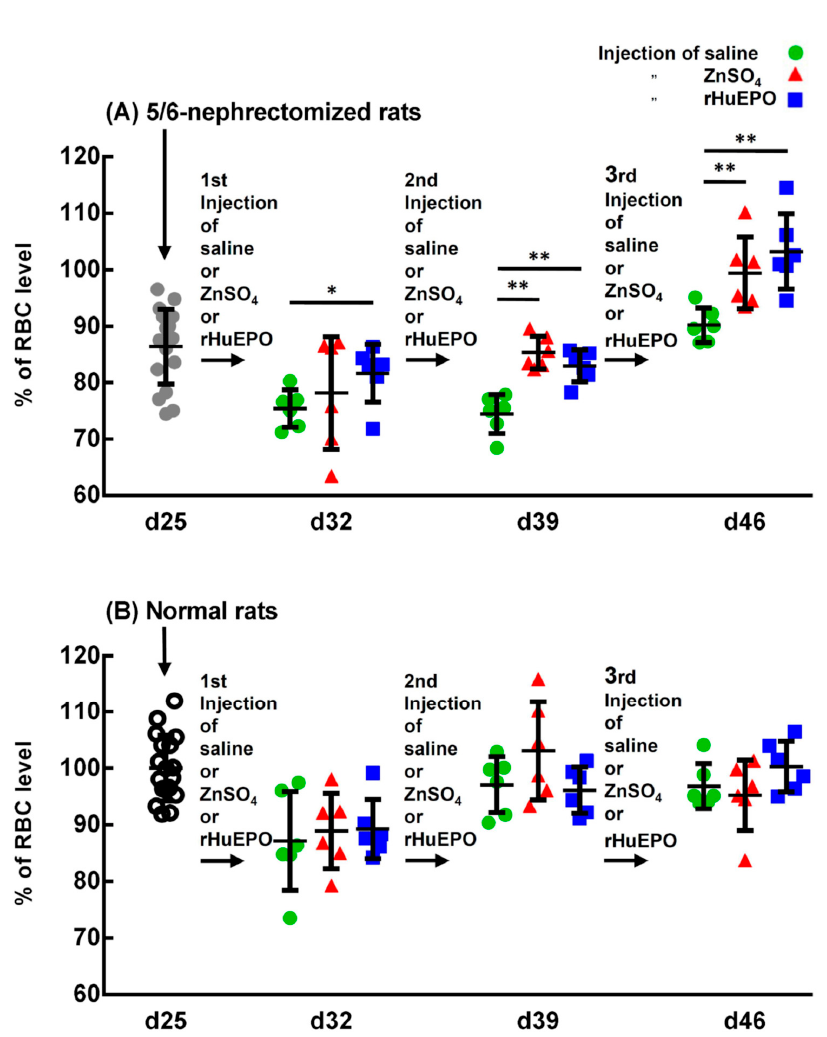
Figure 4. Comparison between the injection of saline, ZnSO 4 , or rHuEPO on the RBC level of 5 / 6-nephrectomized and normal rats. ( A ) Injection of saline, ZnSO 4 , or rHuEPO on the RBC levels of 5 / 6-nephrectomized rats. Rat blood was drawn from the 5 / 6-nephrectomized rats (25 days post surgery); then, the rats were injected with saline, ZnSO 4 , or rHuEPO. Every 7 days, blood was drawn, and saline, ZnSO 4 , or rHuEPO was injected. The collected blood was used to measure RBC levels and other hematological indices. * and **: Significant di ff erence between ZnSO 4 - or rHuEPO- and saline-injected rats (* p < 0.05; ** p < 0.01; n = 6). ( B ) Injection of saline, ZnSO 4 , or rHuEPO on the RBC level of normal rats. Normal rats (same age and lot as the 5 / 6-nephrectomized rats) were subjected to the same procedure described above. This figure is representative of three independent